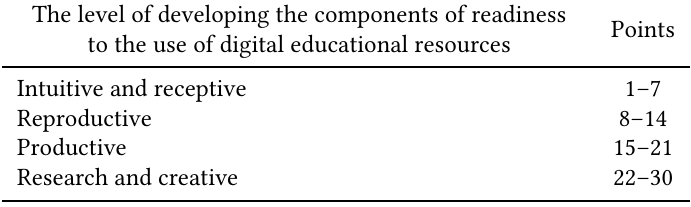
Table 1 Table of distribution of the number of points received by the respondents according to the levels of developing the components of their readiness to use digital educational resources. The level of developing the components of readiness to the use of digital educational